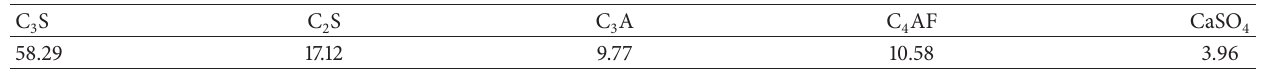
Table 2: Mineral composition of the P ⋅ II 52.5 Portland cement (% by